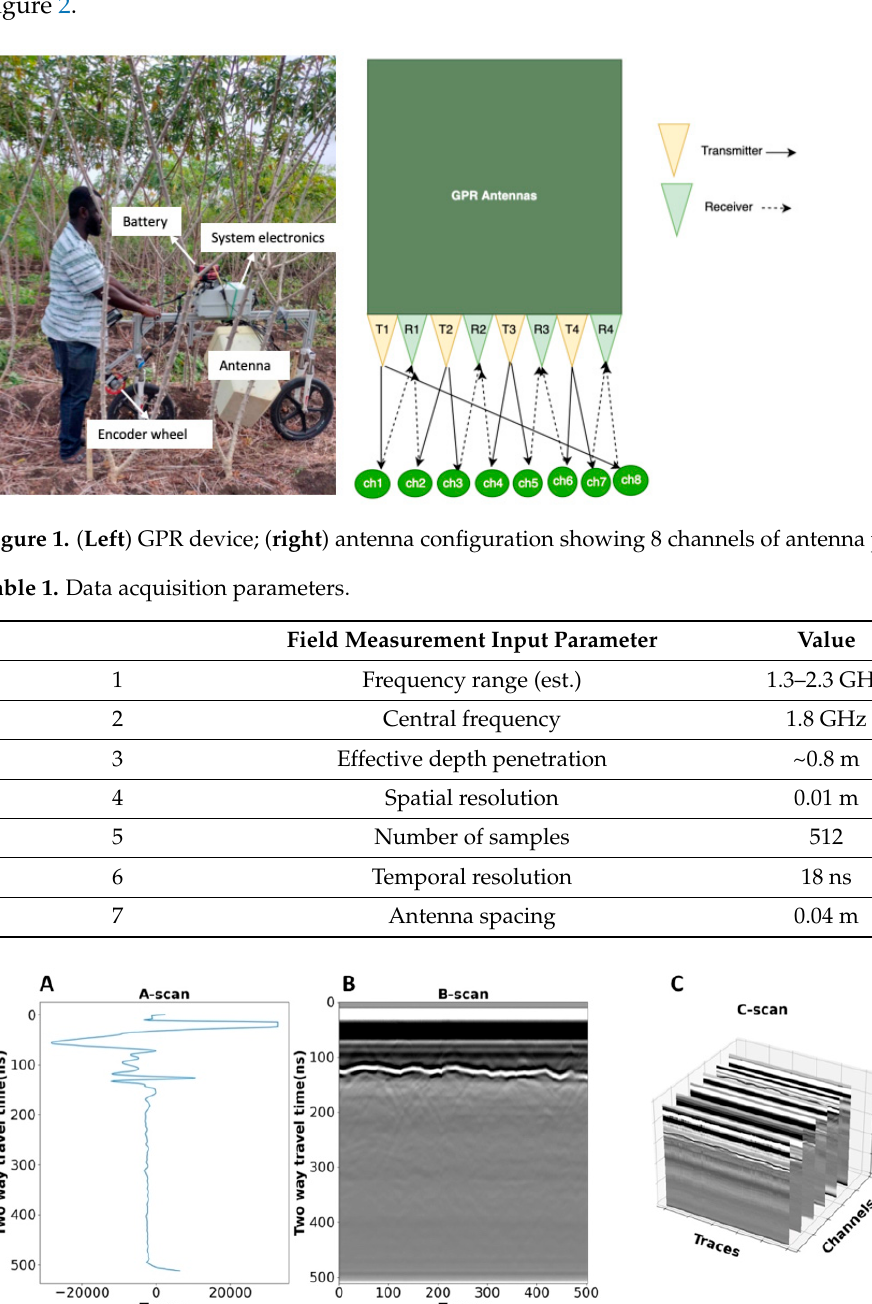
Figure 2. GPR radargram visualization: ( A ) A-scan representing the signal received via a single out- going pulse at a given transmission–reception antenna’s location; ( B ) B-scan representing the series